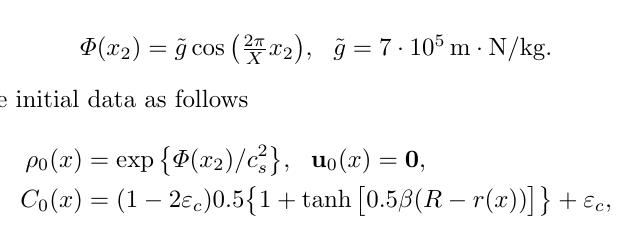
case λ 1 = 4 10 − 6 J m 2 / kg and A ψ = 0 . 5 · ·